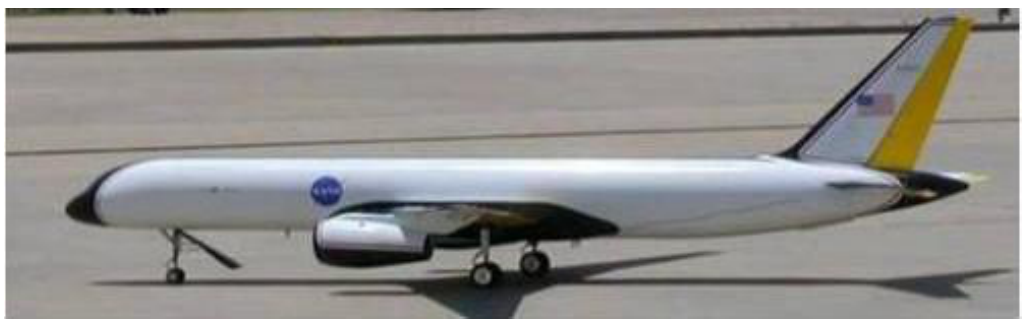
Figure 1. The NASA generic transport